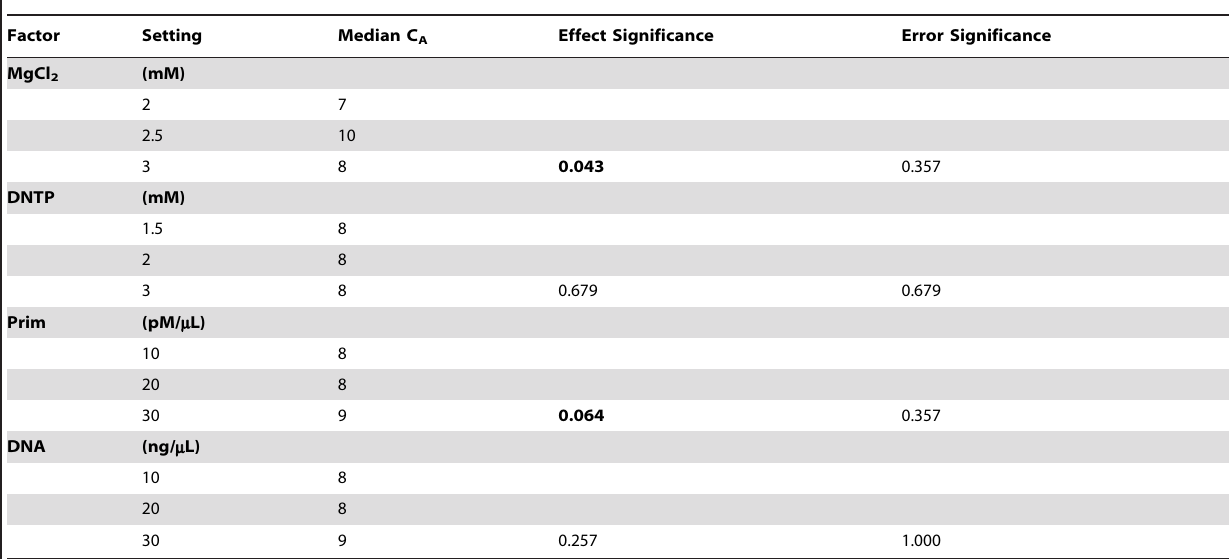
Table 3. Nonparametric Response